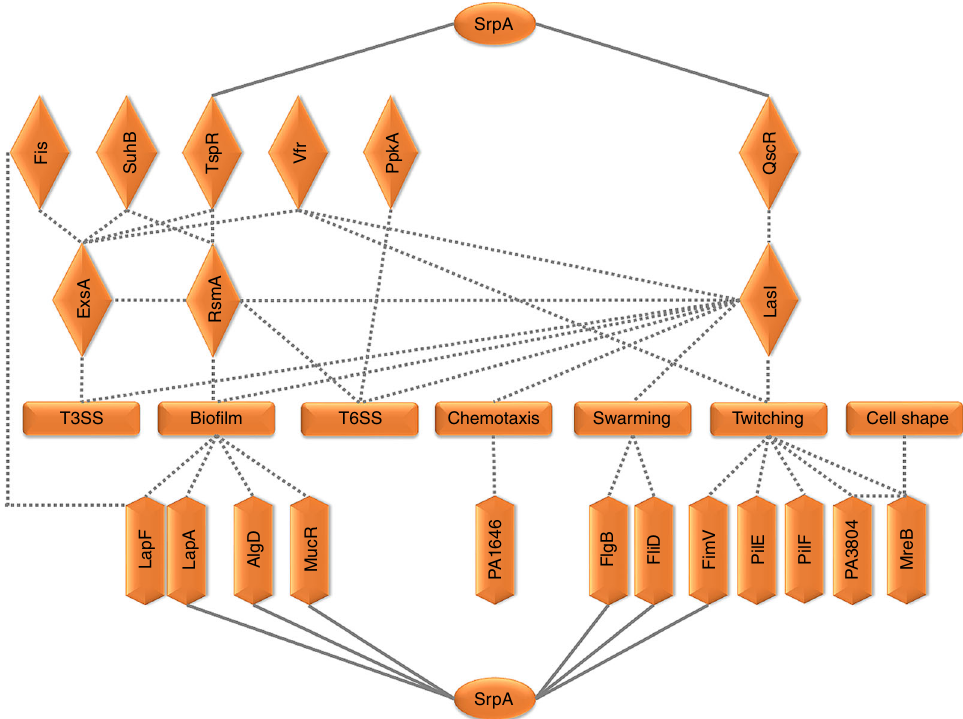
Fig. 10 Schematic representation of the SrpA regulatory web in P. aeruginosa . The regulatory network includes the cellular processes and the genes signi fi cantly in fl uenced by the SrpA regulator. It also includes the genes involved in the indicated cellular processes since they have SrpA-binding sites in their promoter regions. PA1646 encodes a putative methyl-accepting chemotaxis transducer and highly expressed in the absence of SrpA. PA3804 encodes a putative cytoskeleton protein RodZ required for the assembly of actin cytoskeleton MreB. Solid lines represent downstream genes with putative SrpA- binding site in their promoters. Dotted lines represent direct or indirect regulatory relationships that have been established previously. SrpA is depicted in oval textboxes. Regulators are depicted in diamond textboxes. Structural proteins or enzymes are depicted in elongated hexagon textboxes. Cellular processes are depicted in rectangle